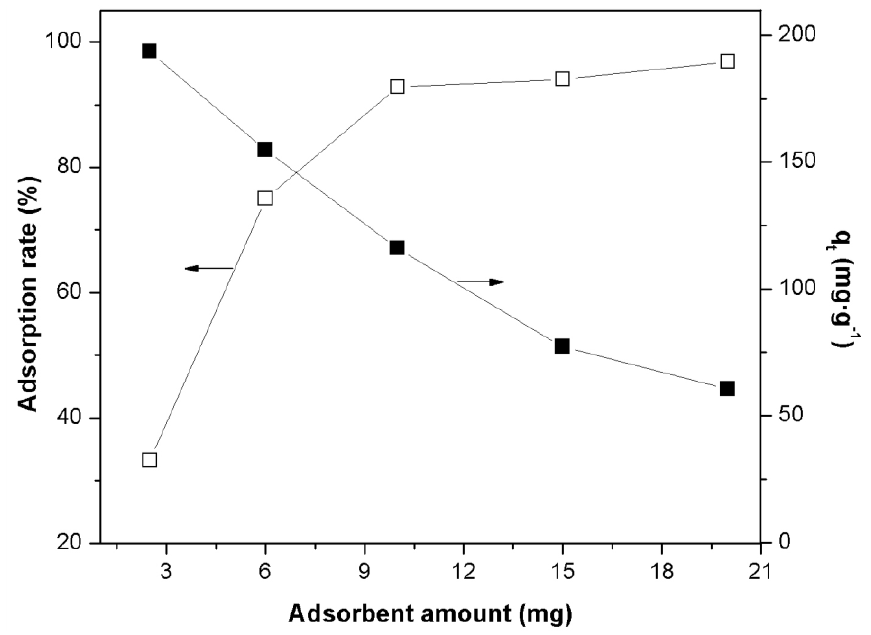
Figure 3. Effect of adsorbent amount on the adsorption rate (left y-axis) and adsorbed amount q t (right y-axis) on the adsorption of azo-dye Orange II onto Fe(BTC) (initial dye concentration: 25 mg·L −1 ; contact time: 300 min; temperature: 298 K; pH